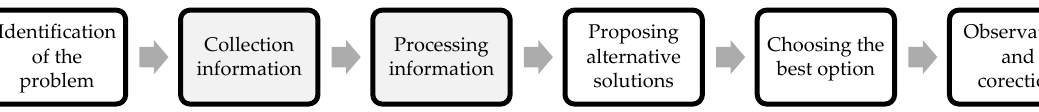
Figure 2. Model of the decision-making process. Source: own study based on (Peters 1999 ).